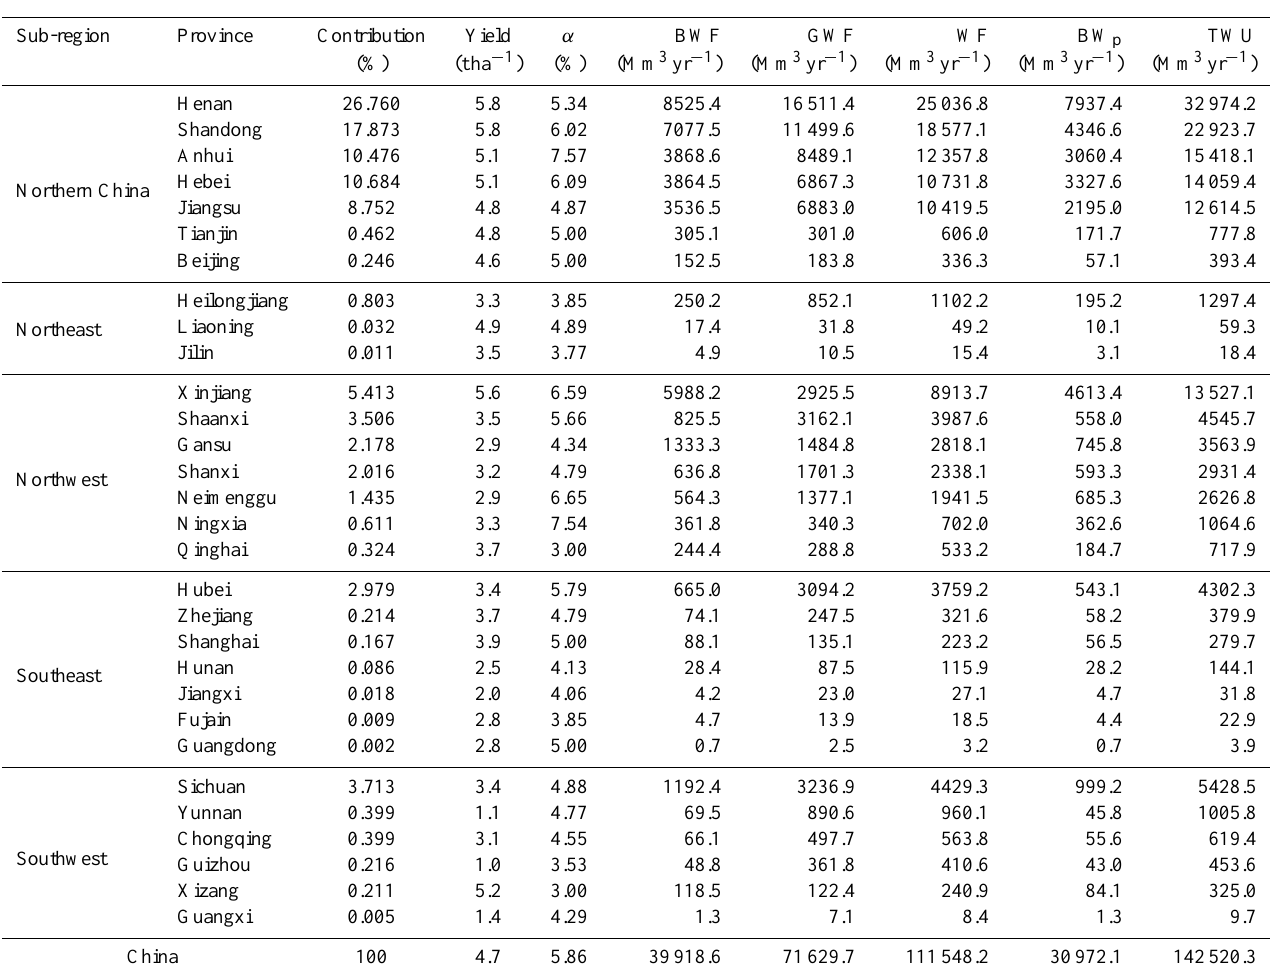
Table 1. Water use of wheat production for the 30 provinces of China in 2010.